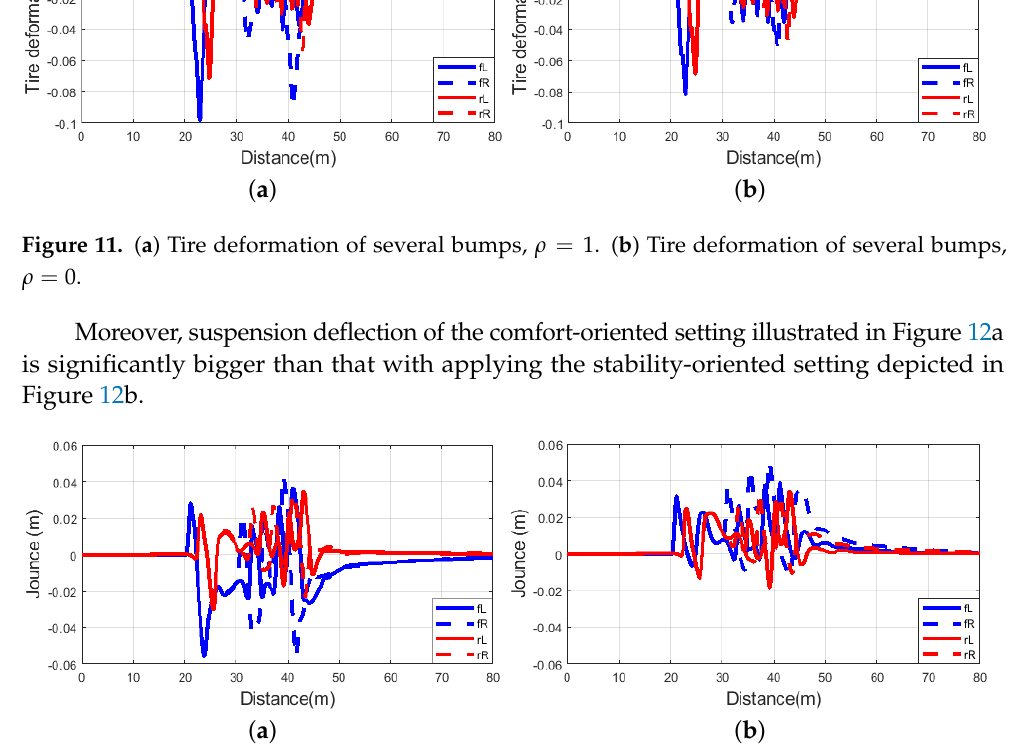
Figure 12. ( a ) Suspension deflection of several bumps, ρ = 1. ( b ) Suspension deflection of several bumps, ρ =